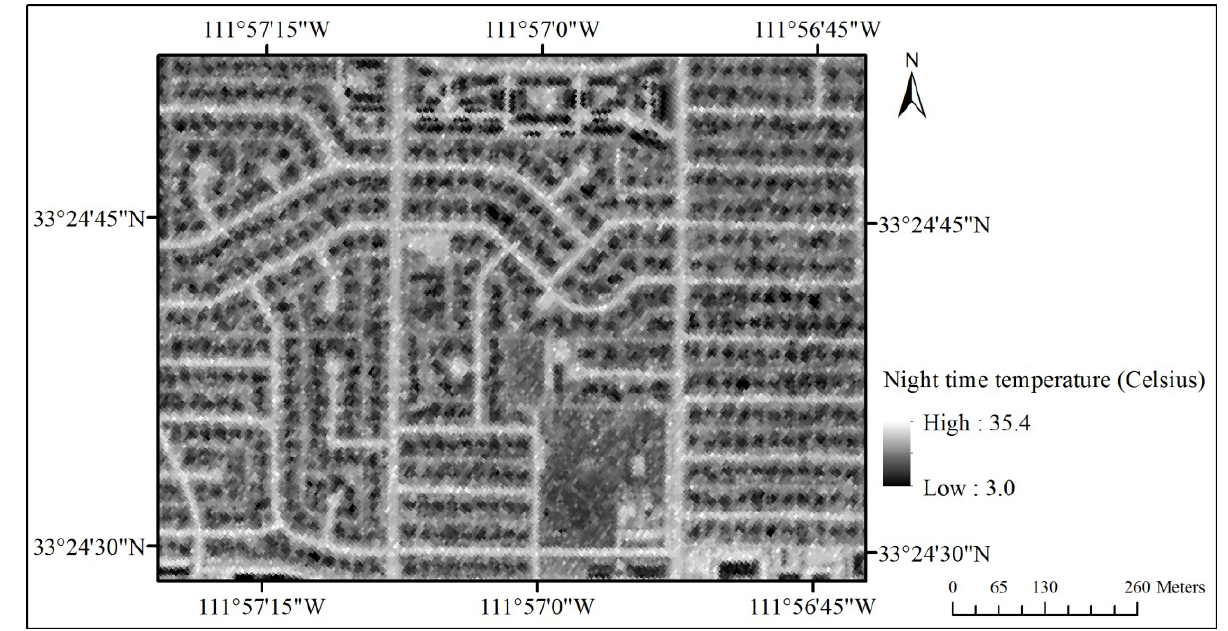
Figure 16. Daytime temperature derived from MASTER imagery.